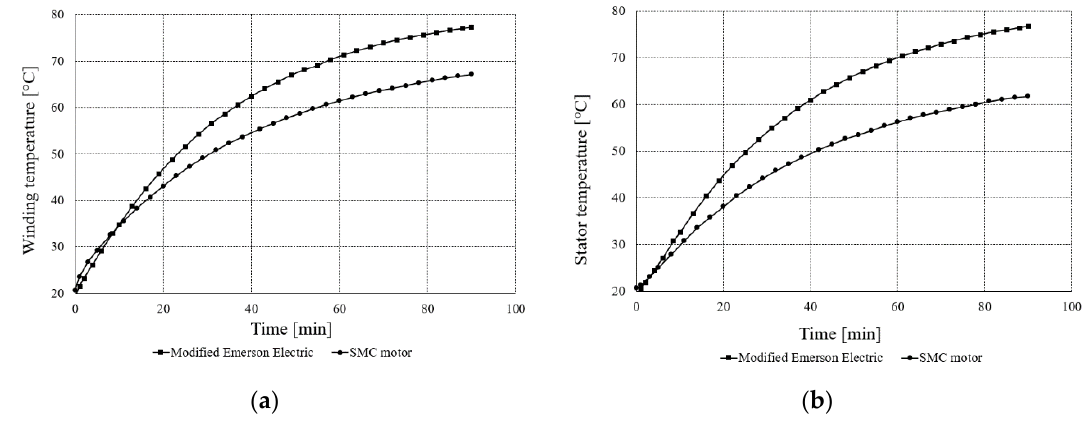
Figure 10. ( a ) Temperature of windings for the modified Emerson Electric motor and SMC motor; ( b ) temperature of stators for modified Emerson Electric motor and SMC motor, T = 0.35 Nm, n = 4400 rpm.